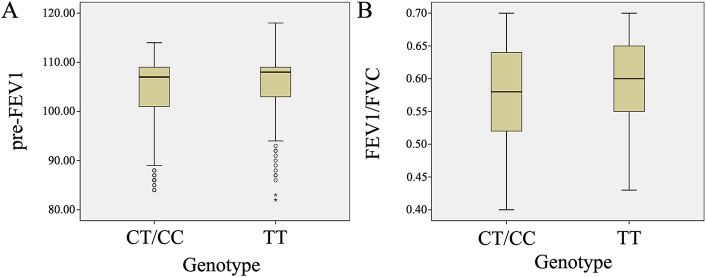
The association between ABHD2 polymorphism rs12442260 and pulmonary function under a dominant model.(A) Rs12442260 is associated with pre-FVE1 in controls; (B) Rs12442260 is associated with FEV1/FVC ratio in patients with COPD.